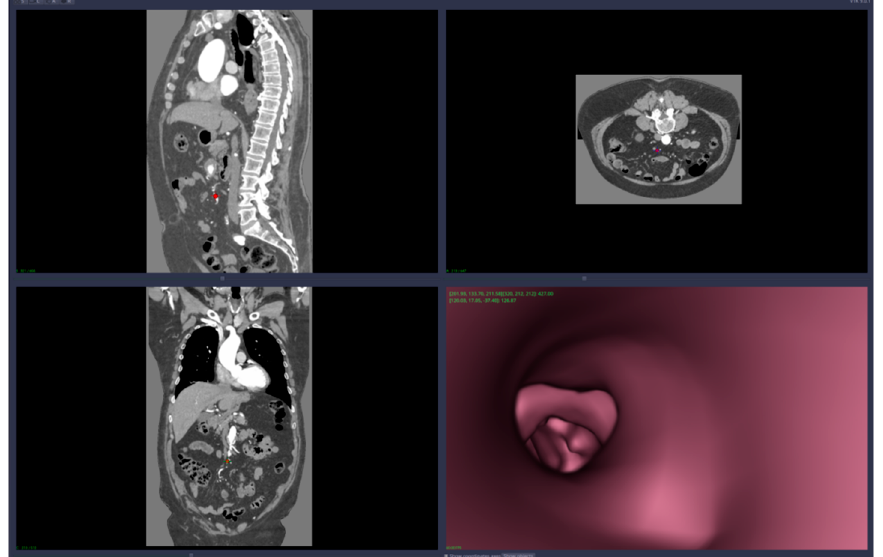
Figure 3. Virtual angiography—“normal” zone of the mesenteric artery, before the aneurysm (direction is opposite to the blood flow).